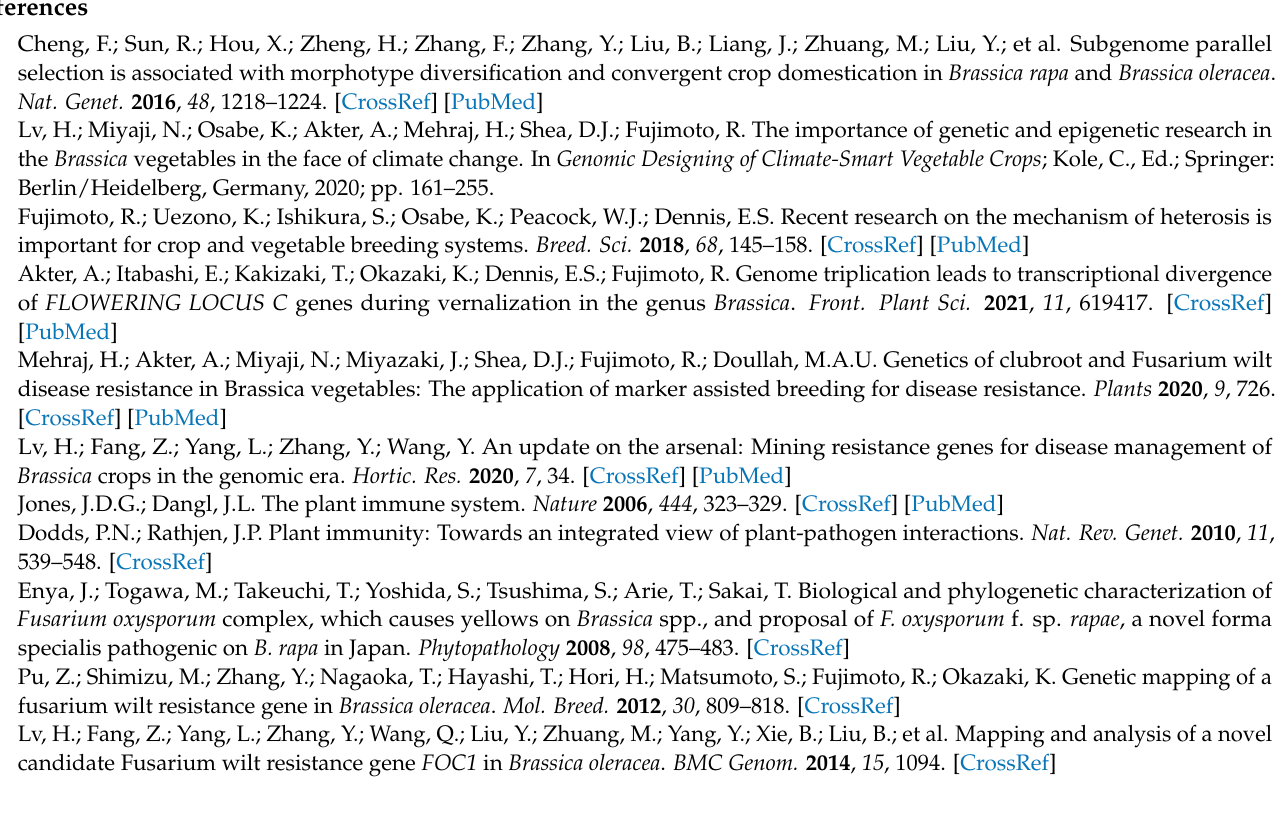
derived from YBCG-11 × YBCG-13 hybrid, Figure S3: QTL-seq results of all chromosomes of F 2 populations derived from YBCG-11 × YBCG-14 hybrid, Figure S4: Overlapped candidate genes in three F 2 populations, Figure S5: QTL-seq results of all chromosomes of F 2 populations derived from YBCG-08 × YBCG-09 hybrid, Table S1: Assessment of Fusarium yellows resistance by inoculation test, Table S2: Genes located on candidate locus detected by QTL-seq in four populations by 95% significance, Table S3: NBS-LRR encoded genes in significant QTLs, Table S4: Genotype using focbr1- 2m marker in resistant and susceptible plants derived from F 2 population, Table S5: List of cultivars used in this study, Table S6: List of primer